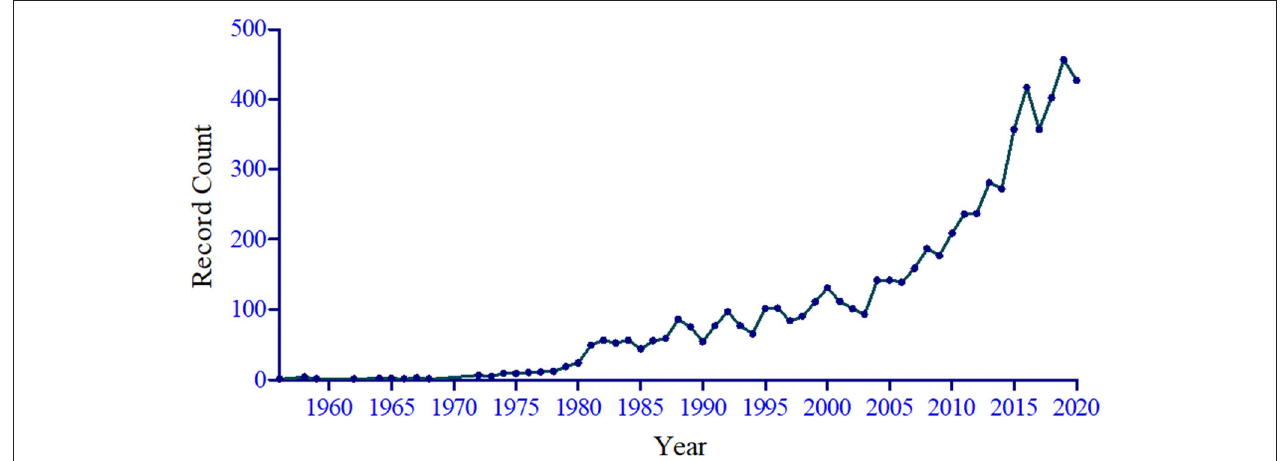
FIGURE 1 | Number of publications issued per year in the occupational stress field from 1956 to